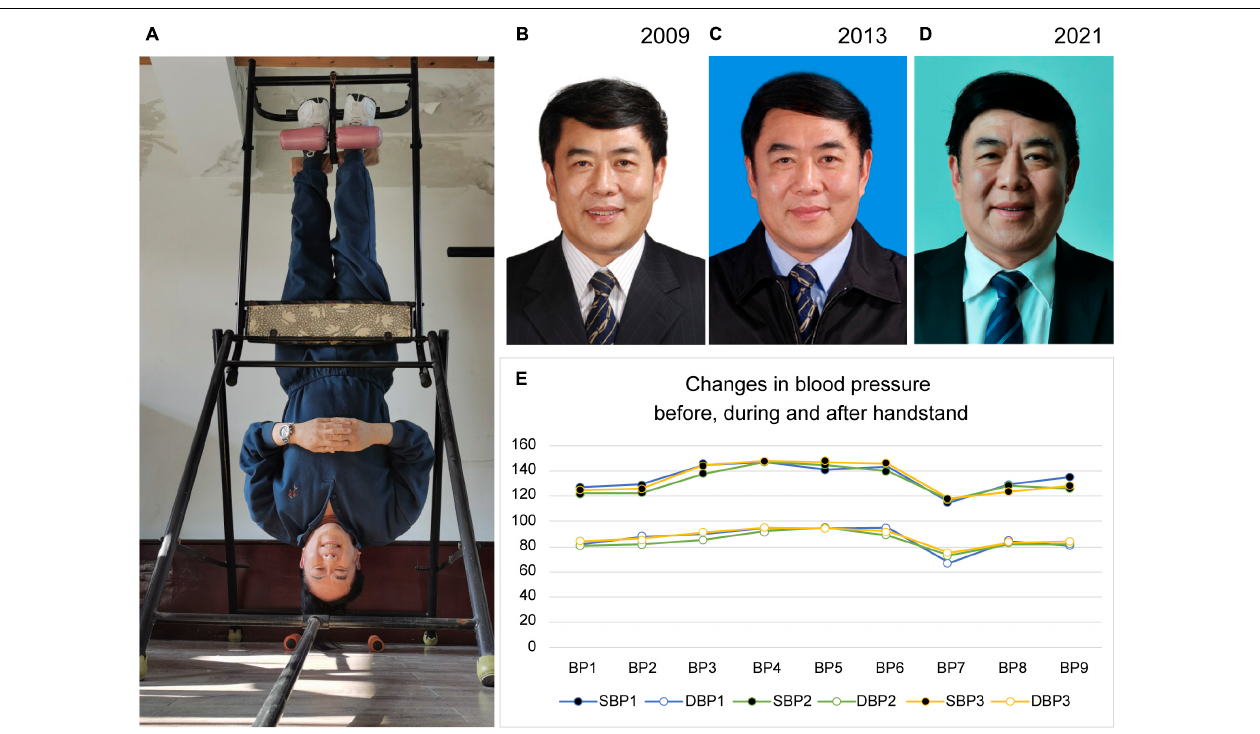
FIGURE 1 | Changes in appearance over 10 years and changes in blood pressure during device use. (A) The method of passive handstand exercise. When using the device, the feet are placed in the foot retainer, and the support frame is held to lower the body upside down. (B–D) Participant’s appearance in the 2009, 2013, and 2021 assessments. (E) Blood pressure changes (recorded every 2 min) before, during, and after a handstand are as follows: rest (BP1), moment before handstand (BP2), handstand for 2 min (BP3), handstand for 4 min (BP4), handstand for 6 min (BP5), handstand for 8 min (BP6), end of handstand exercise and return to normal position (BP7), rest at 2 min after the handstand (BP8), and rest at 4 min after the handstand (BP9). SBP, systolic blood pressure; DBP, diastolic blood pressure. Permission to utilize photographs was